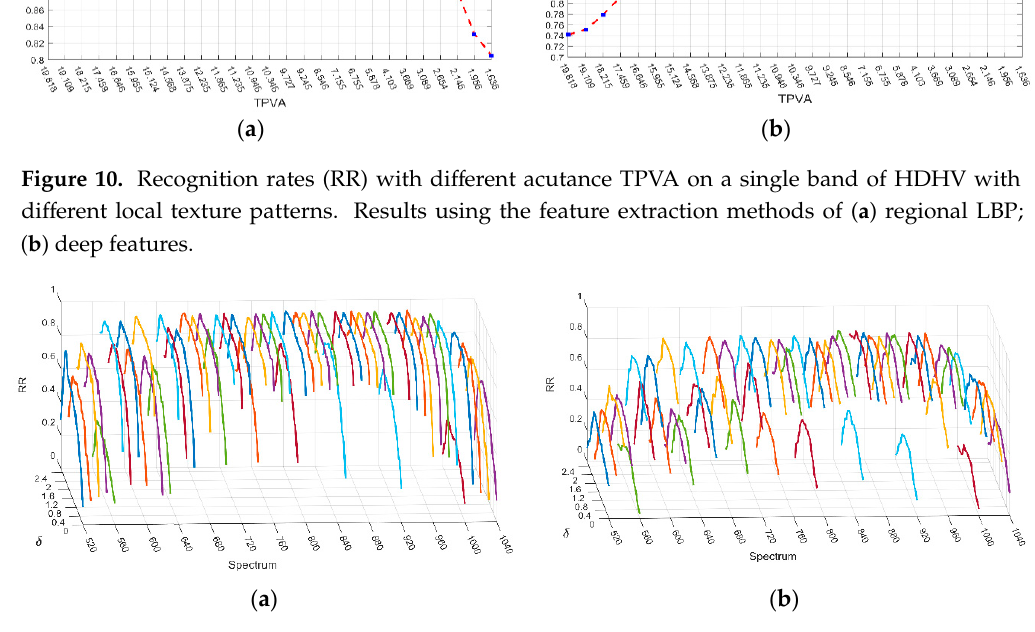
Figure 11. Recognition rates (RR) with different acutance (corresponding to δ ) for every band (spectrum) of HPV using different local texture patterns. Results using the feature extraction methods of ( a ) CompCode; ( b ) deep features.